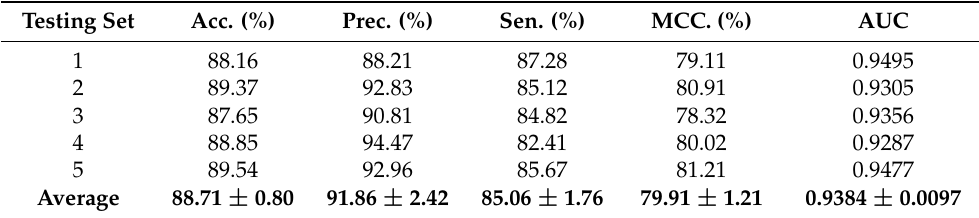
Figure 5. The ROC curve of the SVM classifier on the H. pylori dataset. Furthermore, the prediction experiment of KNN has been carried out and the average results are obtained by adopting the same feature extraction method. Table 6 summarizes the prediction result of the different prediction models. The results of RF are significantly better than SVM and KNN on the Yeast dataset. For example, the accuracy gaps between RF and SVM are 12.09% in the Yeast dataset and 3.85% in the H. pylori dataset. Similarly, the accuracy gaps between RF and KNN are 18.08% in the Yeast dataset and 1.51% in the H. pylori dataset. As a result, we can conclude that the RF classifier is more accurate and outstanding than SVM and KNN.